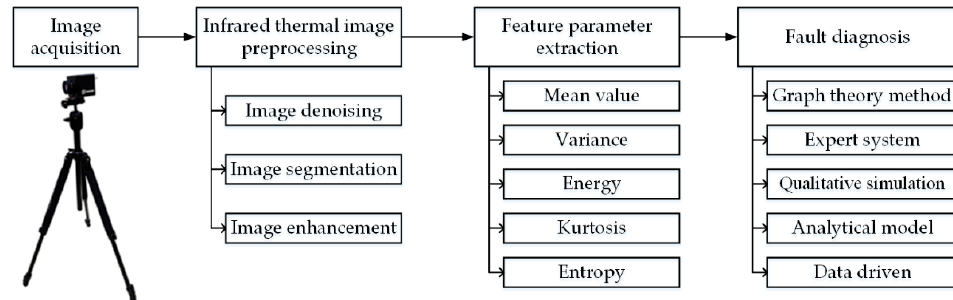
Figure 7. The fault diagnosis process of rotating machinery.